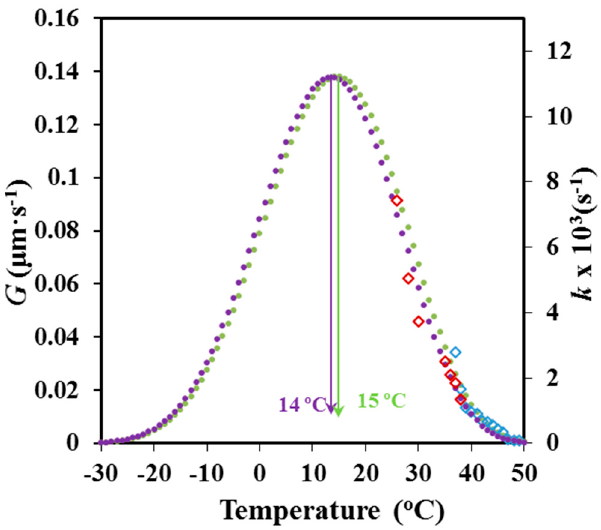
Figure 16. Temperature dependence of the crystal growth ( • , ♦ ) and overall crystallization ( • , ♦ ) rate. Simulated data is represented by circles and experimental data by rhombus.